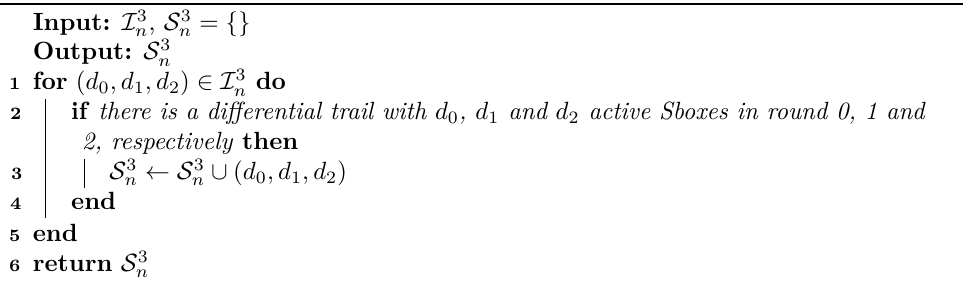
Algorithm 1: Searching 3-round valid